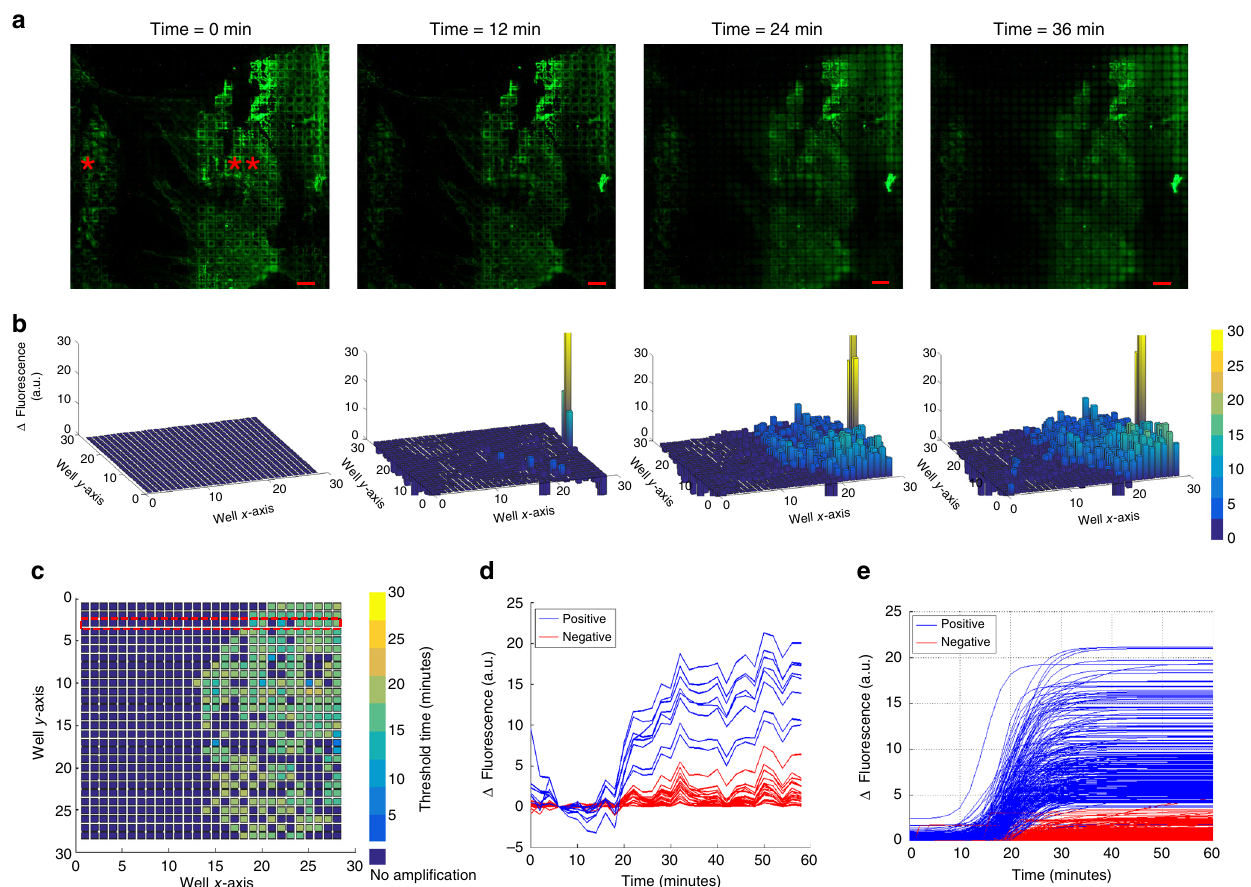
Fig. 5 On-chip RT-LAMP: cancer vs. non-cancer control. a Raw fl uorescence images of real-time RT-LAMP with prostate cancer tissue on right and non- cancer (mouse skeletal muscle) tissue on left of chip at four different time points (*Non-cancer, **Cancer) (scale bar: 200 µ m). b Fluorescence bar graphs of the raw images showing a differential increase in fl uorescence over time. The gain in fl uorescence over time is calculated taking time = 0 image (initial) as the reference. Note the ampli fi cation occurs only for the cancerous tissue. c Spatial threshold analysis showing the spatially mapped threshold times. Each pixel is 100 µ m × 100 µ m. d Raw ampli fi cation curves of a row showing positive and negative wells marked in red in “ c ” . e Fluorescence curves for all wells after curve fi results clearly demonstrate that only cancerous regions ampli fi ed. demonstrating an increase in fl uorescence over time and Fig. 6b To visualize the spatial heterogeneity in TOP2A mRNA across shows the spatial threshold time analysis, re fl ecting variations in the tissue, we plotted the fraction of cancerous tissue per well TOP2A mRNA across the tissue. Figure 6c shows confocal fl uorescence micrographs of nuclei (blue) and TOP2A mRNA (color bar) against spatially mapped threshold times to create a 4- dimensional plot (Supplementary Fig. 10). Taking a given fraction FISH (red). The TOP2A mRNA FISH micrograph was then of cancerous tissue per well as a reference for the starting sample pixelated at the same spatial resolution as the spatial threshold amount in wells, the heterogeneity in TOP2A expression is evi- time maps and displayed in Fig. 6d. Supplementary Fig. 13 shows dent as variation in threshold times in those wells as seen in an independent repeat experiment similar to the above. At 36- Supplementary Fig. 10i. It can be observed that wells with none to min reaction times, the detection sensitivity of the RT-LAMP was negligible fraction of cancerous tissue (dark red) either do not amplify or have very high threshold times, whereas regions with high fraction of cancerous tissue (yellow) tend to show lower threshold times. Supplementary Fig. 11 shows a repeat experi- ment with FTIR. Comparison with mRNA FISH . For further validation, we per- formed mRNA FISH and microchip spatial ampli fi cation on adjacent tissue sections. FISH probes for human TOP2A mRNA were con fi rmed to speci fi cally stain human prostate cancer cells (PC3, LNCaP) and not stain mouse fi broblast or muscle cell lines (3T3, RAW 264.7) which do not express TOP2A (Supplementary Fig. 12). The probe sequences are provided in Supplementary Table 2. Figure 6a shows baseline-subtracted fl uorescence images for the microchip ampli fi cation at three different time points,